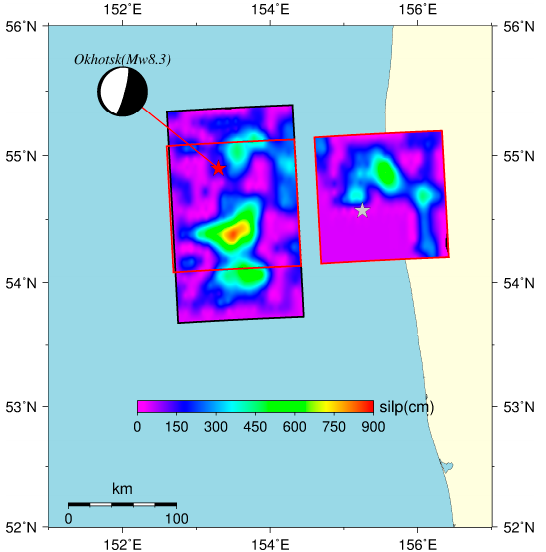
Figure 3. Coseismic slip model of the 2013 Okhotsk M w 8.3 earthquake. The beach ball (top left corner) is the mechanism of the Okhotsk earthquake. The slip model includes two-stage slip model which is composed of the southward rupture (starting at the hypocenter, denoted by red star) and the northward rupture (starting at the second hypocenter, denoted by grey star). The smaller fault is located at the red rectangle in the larger fault and the maximum slip is approximately 9 m [21].